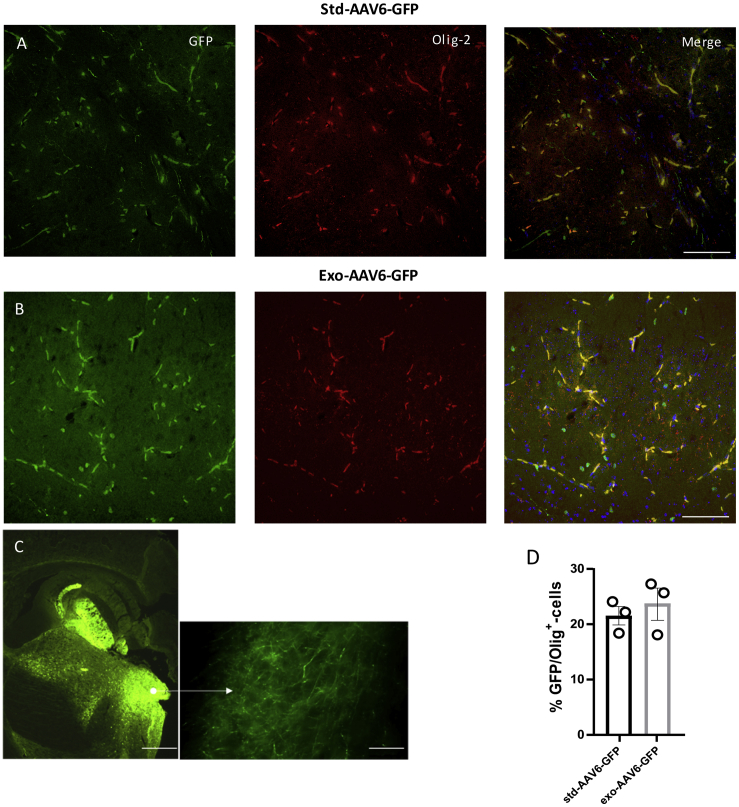
std-AAV6 and exo-AAV6 Mediate an Oligodendrocyte-Preferring Tropism in the Dorsal Striatum(A and B) Confocal imaging shows a high co-localization between GFP (green) and the oligodendrocyte marker (Olig-2-red) in the dorsal striatum (DS) expressed with (A) std-AAV6 and (B) exo-AAV6 at 95 days after bilateral injection into the hippocampus. Images were captured by a Leica SP8 confocal microscope at 40× magnification. The merge image showing both channels (GFP-Olig-2) is on the right panel. Scale bar 50 μm. (C) Representative image of GFP within the DS after stereotactic injection of std-AAV6 and exo-AAV6 vectors. Scale bar 100 μm. Fluorescence imaging was by a Leica DM600B. (D) Quantification of the GFP-Olig-2-positive oligodendrocytes transduced by std-AAV6 and exo-AAV6 expressed as percentages of co-localization between GFP and Olig-2 (n = 12). The data were analyzed by two-way ANOVA with Tukey post hoc test. Data are presented as mean ± SEM.